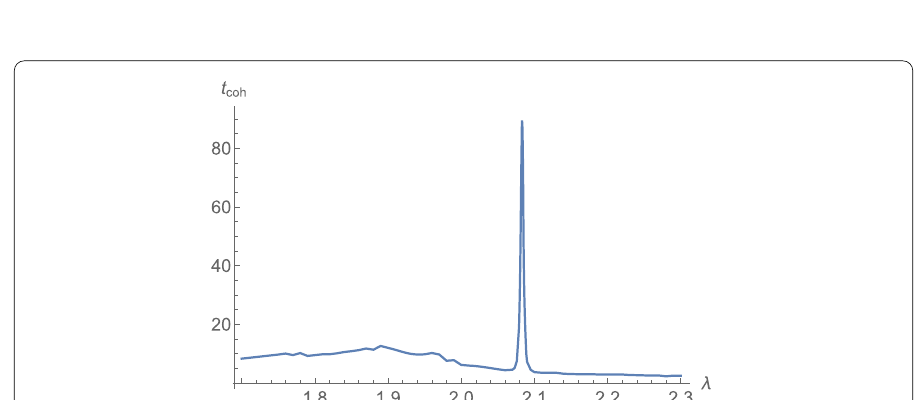
Figure 7 Estimate of the decoherence time t coh associated to | Φ inf (cid:2) as a function of λ for N = 60. We observe that it increases distinctly around λ ≈ 2.083